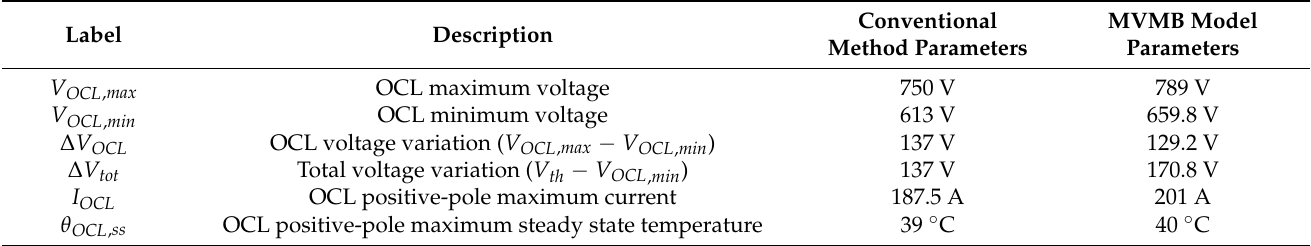
Table 4. Results and techniques comparison for FS 1.